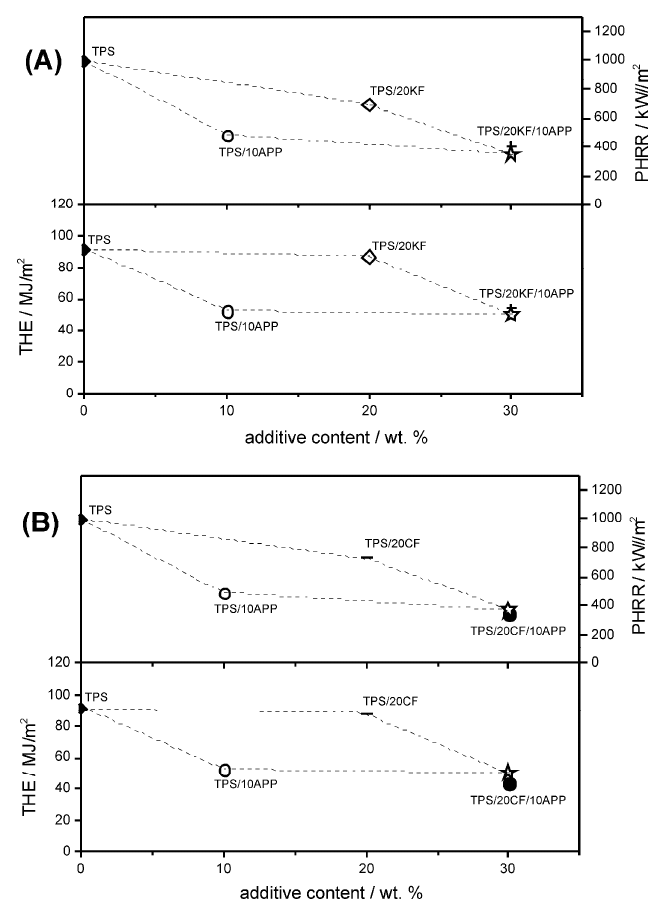
Figure 14. Visualization of superposition (hollow star) and measured PHRR and THE of TPS/20KF/10APP ( A ) and TPS/20CF/10APP ( B ).